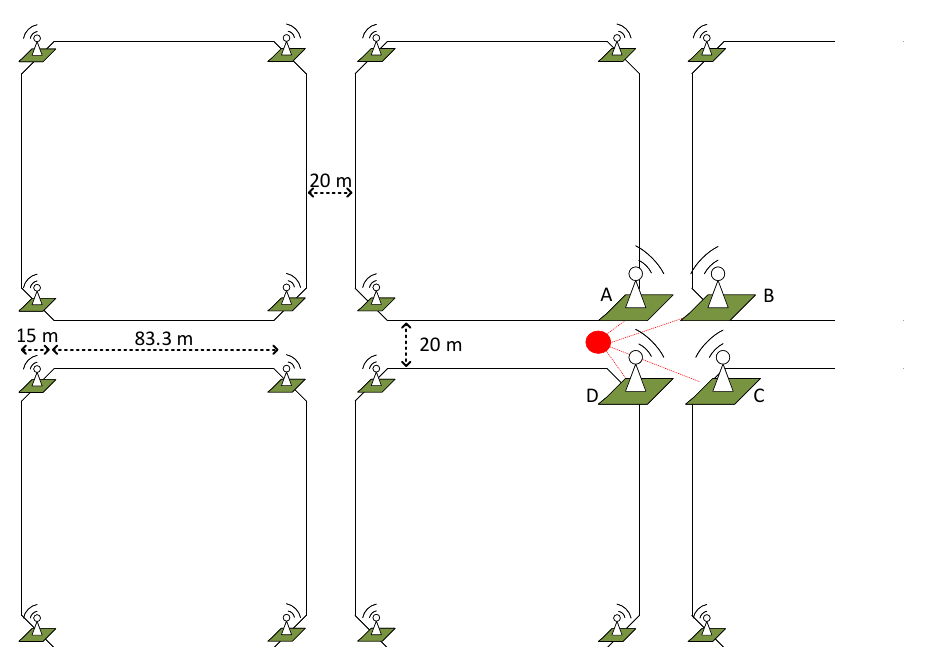
Figure 11. Diagram of the network of sensors (nodes) in the building blocks of the city of Barcelona. The green and white icons represent the sensor devices and the red dot represents an acoustic event.